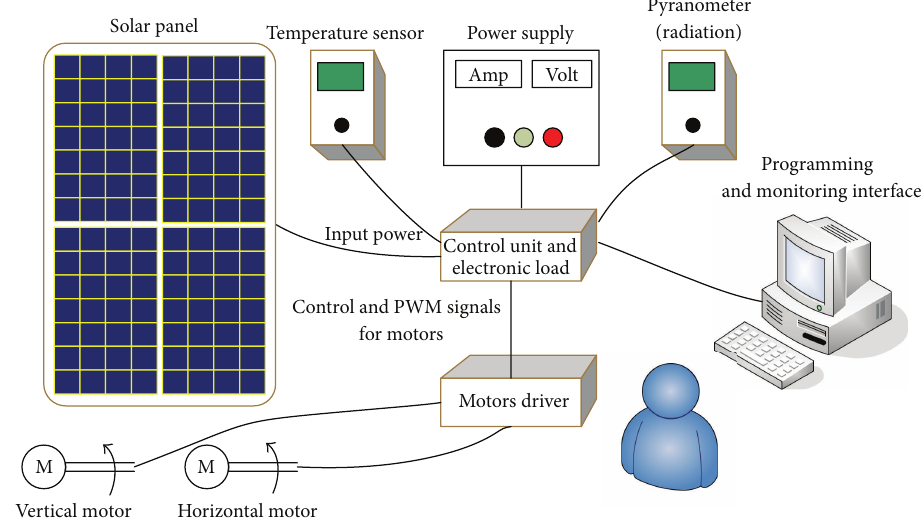
Figure 7: The proposed measurement system block diagram.